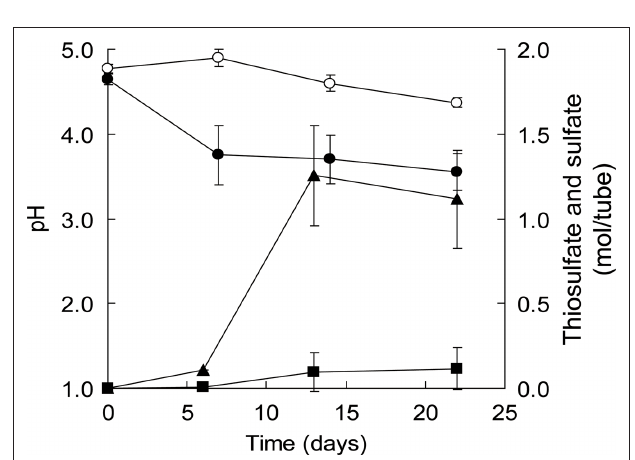
FiguRe 3 | Changes in the medium pH and thiosulfate and sulfate ions during growth of strain THi503 in WS5-S medium with S 0 as the sole energy source. Cells were grown in a 225-mL conical tube containing 50 mL culture. Error bars indicates SD, n = 3. Symbols: circles , pH; triangles , thiosulfate; square , sulfate, filled symbols , + THI503 + S 0 ; empty symbols , − THI503 + S 0 .